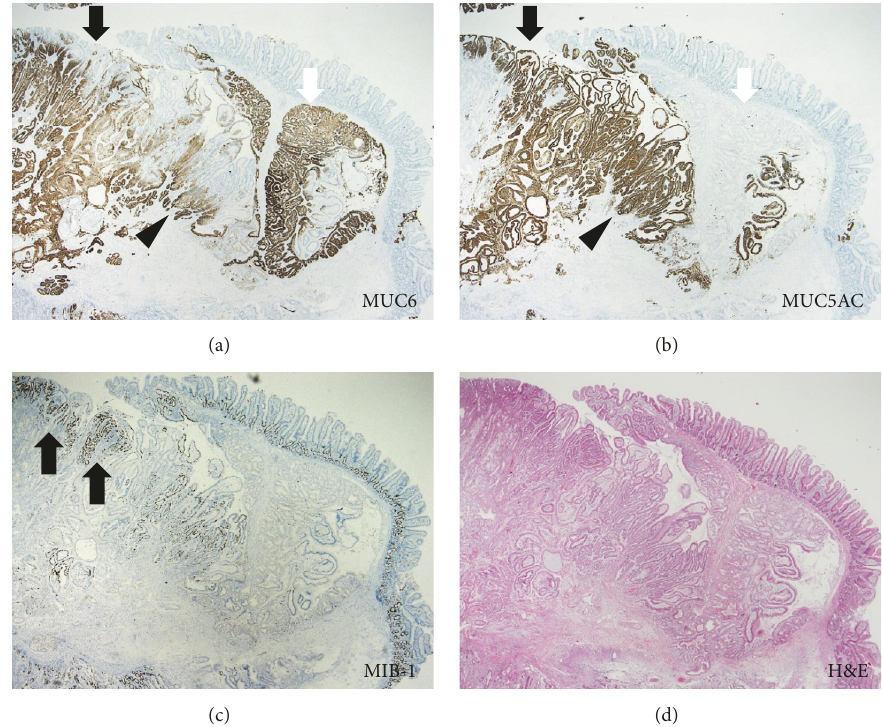
Figure 5: Immunohistochemical images. Proliferated Brunner’s glands are positive for MUC6 (a, white arrow) and negative for MUC5AC (b, white arrow). In contrast, most of the cells with gastric foveolar differentiation (a, black arrowhead; b, black arrowhead) and atypical cells (a, black arrow; b, black arrow) are positive for MUC5AC but are negative for MUC6. Both gastric foveolar metaplasia and atypical cells partly show dual positivity for MUC5AC and MUC6, particularly in the deeper layer (a, arrowhead; b, arrowhead). Some atypical cells showed relatively higher positivity for Ki-67 staining (c, hematoxylin and eosin staining,